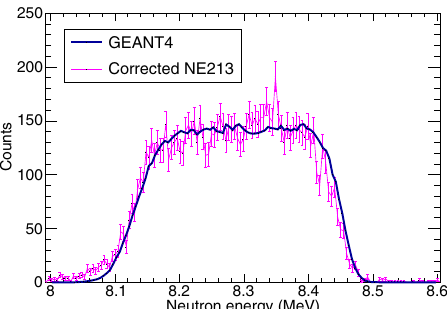
Fig. 4 Incident neutron energy spectrum. The spectrum is shown from the NE-213 detector placed at 30 m with a pulsed beam (magenta points) with corrections for the interaction location within the gas cell applied. The neutron energy spectrum from the 7.98-cm gas cell as predicted by GEANT4 is overlaid (solid blue line) and normalised to reproduce the amplitude of the fl at region between 8.2 and 8.36 MeV. Error bars correspond to a statistical uncertainty of 1 σ